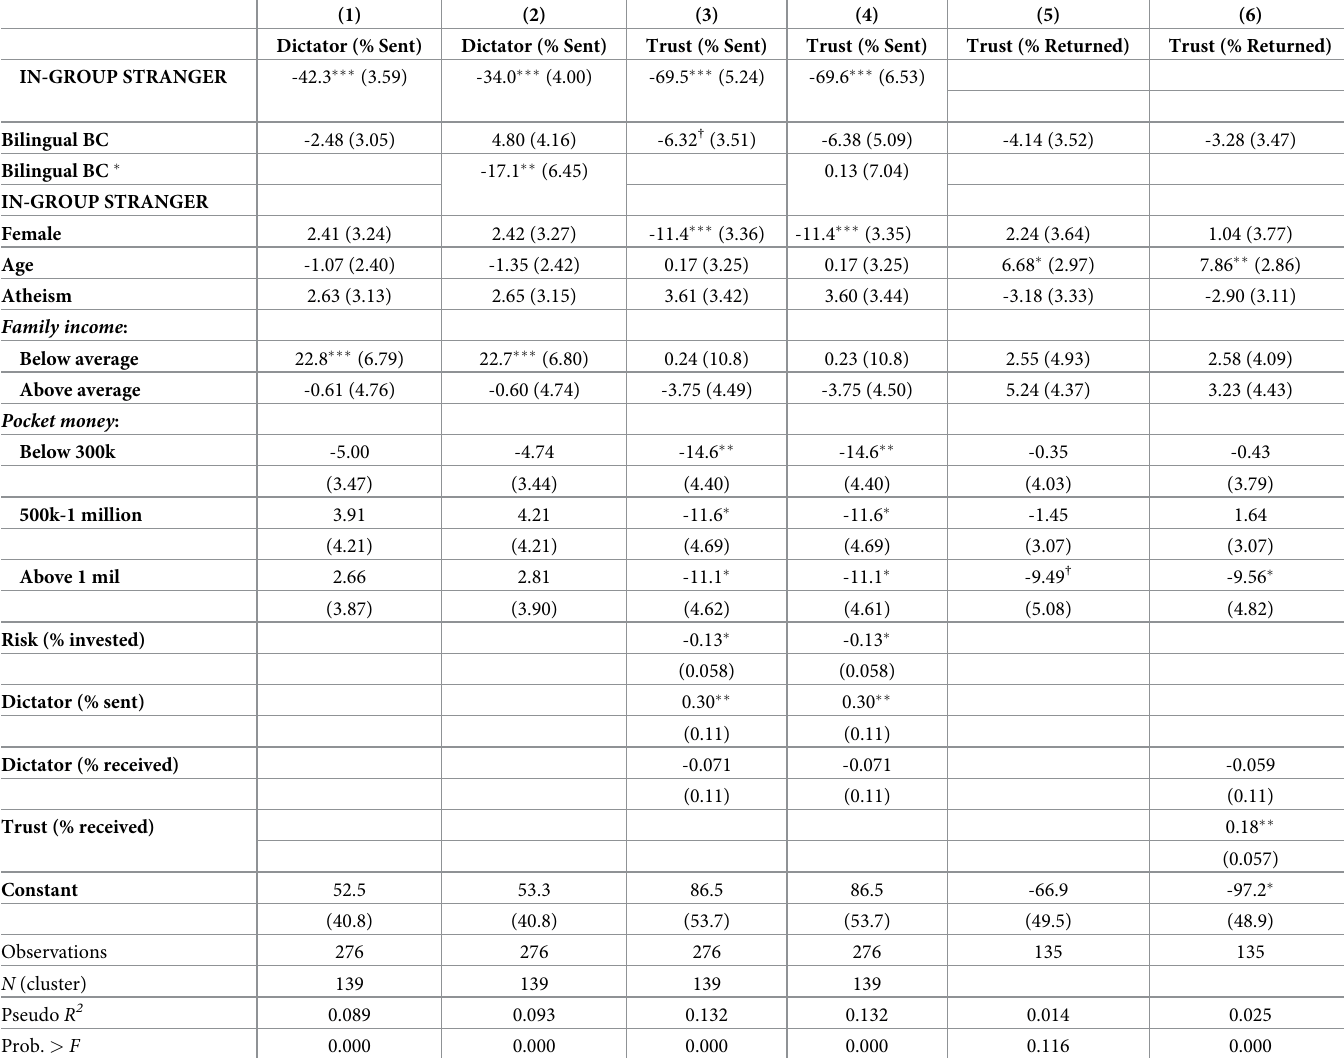
Table 5. Within-school interaction (BC and